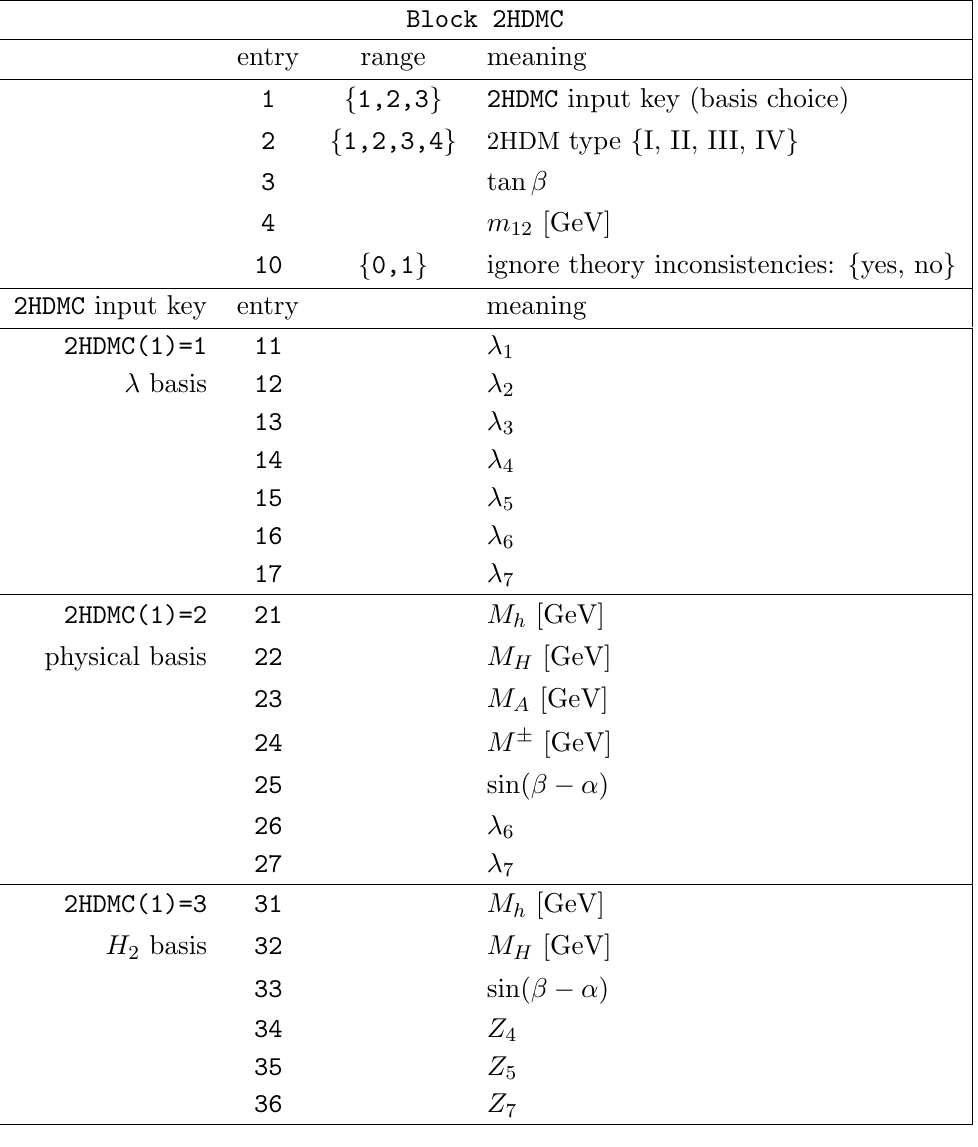
Table 13 . Input parameters of Block 2HDMC . Either entries 11-17, 21-27 or 31-36 have to be speci(cid:12)ed, in accordance to 2HDMC(1). For details on the di(cid:11)erent bases, we refer to refs. [60, 62]. contrast to the run with Block 2HDM , the link to 2HDMC will reveal di(cid:11)erences among